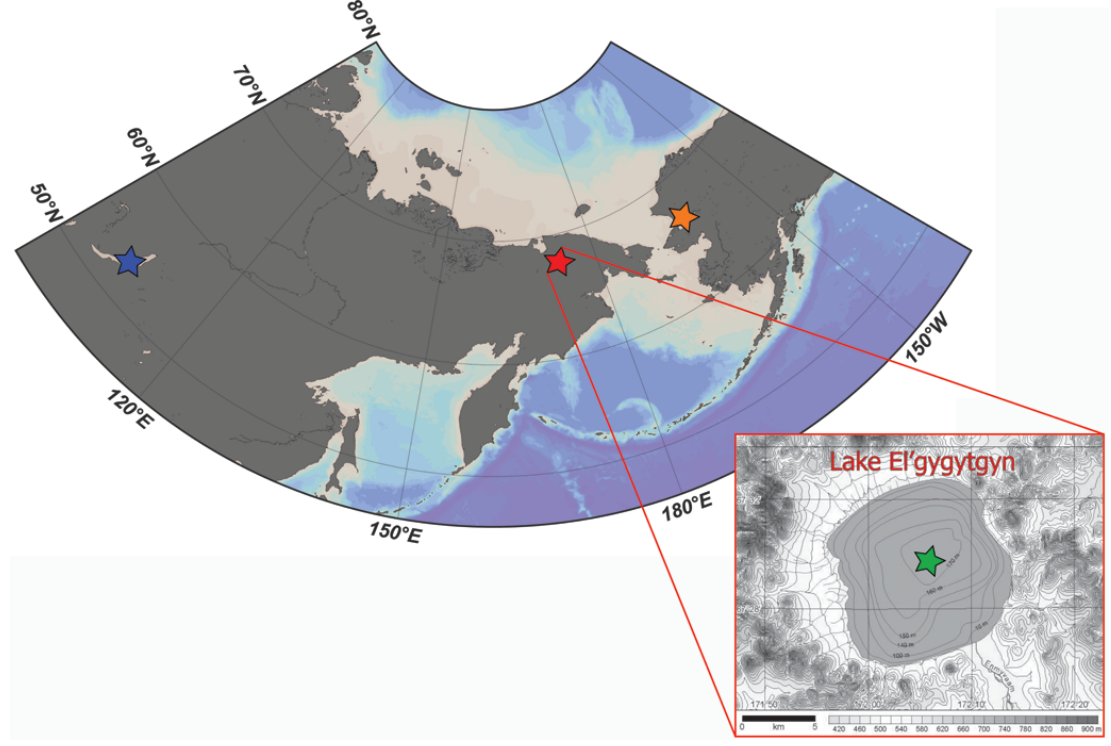
Fig. 1. Location of Lake El’gygytgyn (red star) and corresponding ICDP 5011-1 drill site (green star, inset map) are indicated. Other points of interest to this study and in the region are Lake Baikal (blue star) and the Baldwin Peninsula in Alaska (orange